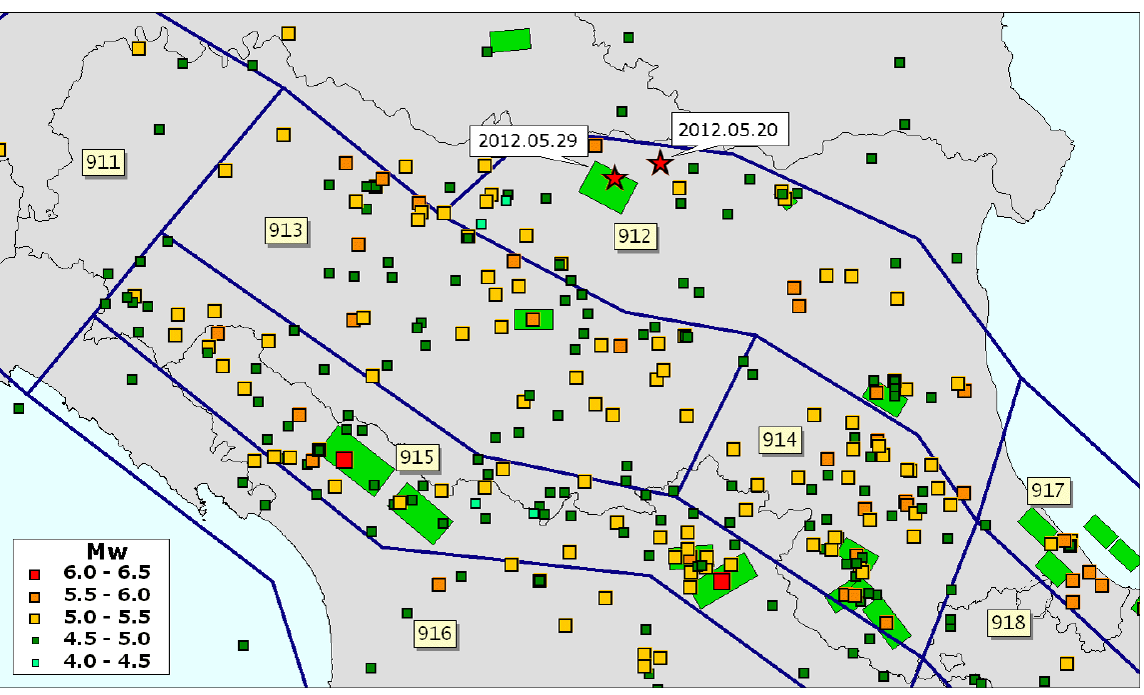
Figure 2. Seismic source zones from the ZS9 model (blue lines), potential seismogenic structures from the DISS database (green boxes), and earthquakes from the CPTI04 catalog (magnitudes mainly derived from historical data) in the northern Apennines. Red stars, epicenters of the two main events of the Emilia earthquake